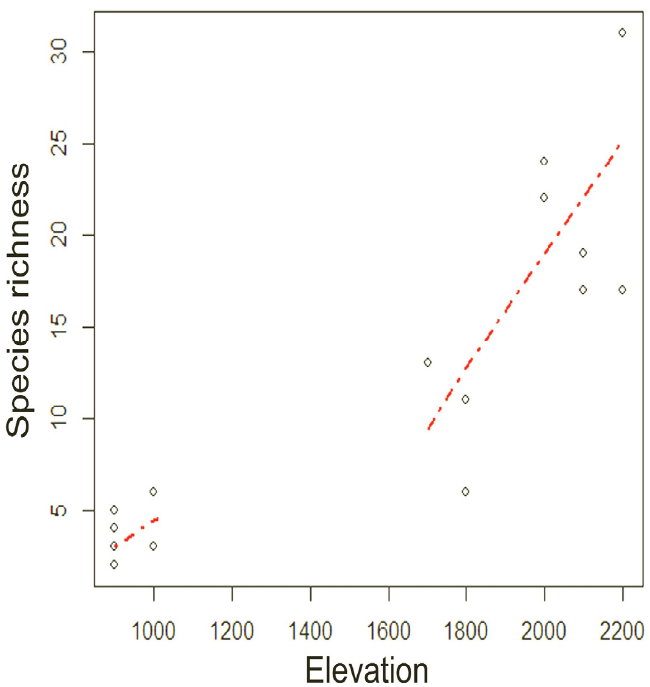
Figure 6. Transect species richness as a function of altitude. In red, the LOWESS regression line, which describes in a non-parametric manner the trend in species richness.